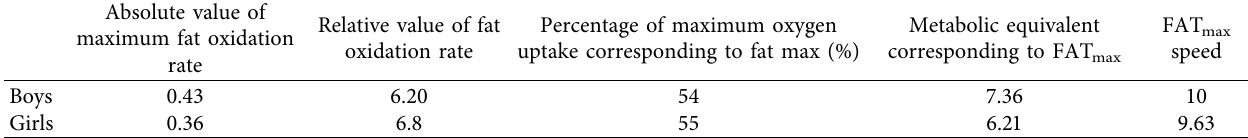
Table 3: Test results of maximum fat oxidation exercise intensity.